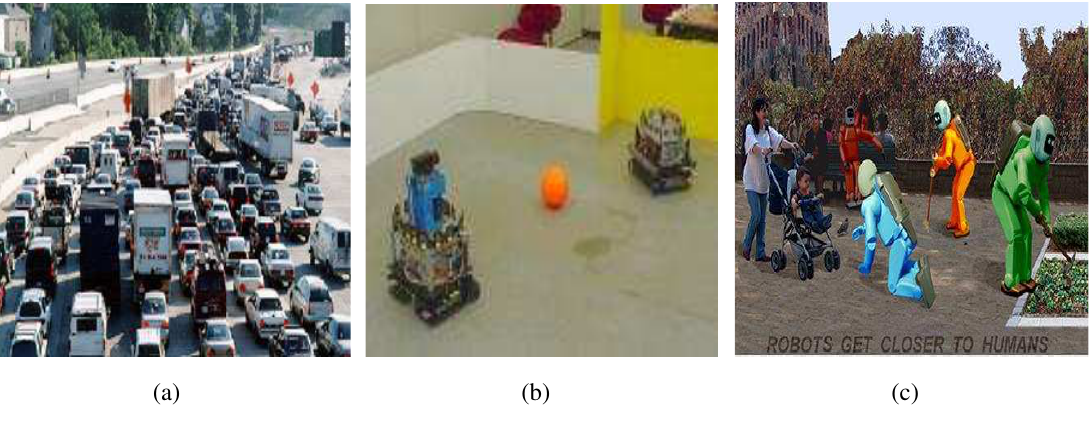
autonomous vehicles (mobile robots) to fulfill the tasks in all these